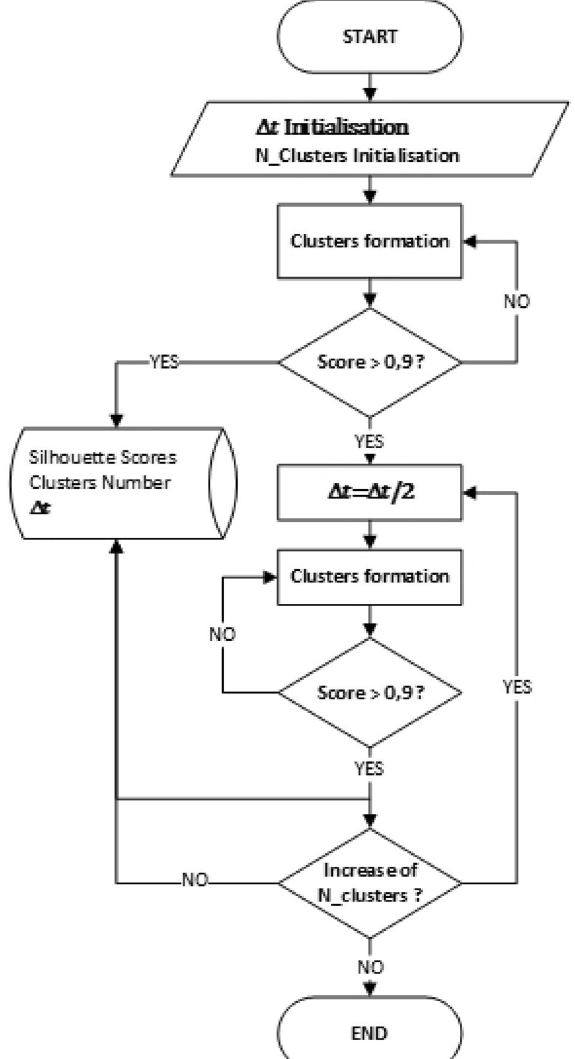
Fig. 4 Grid pitch and cluster number optimization flow